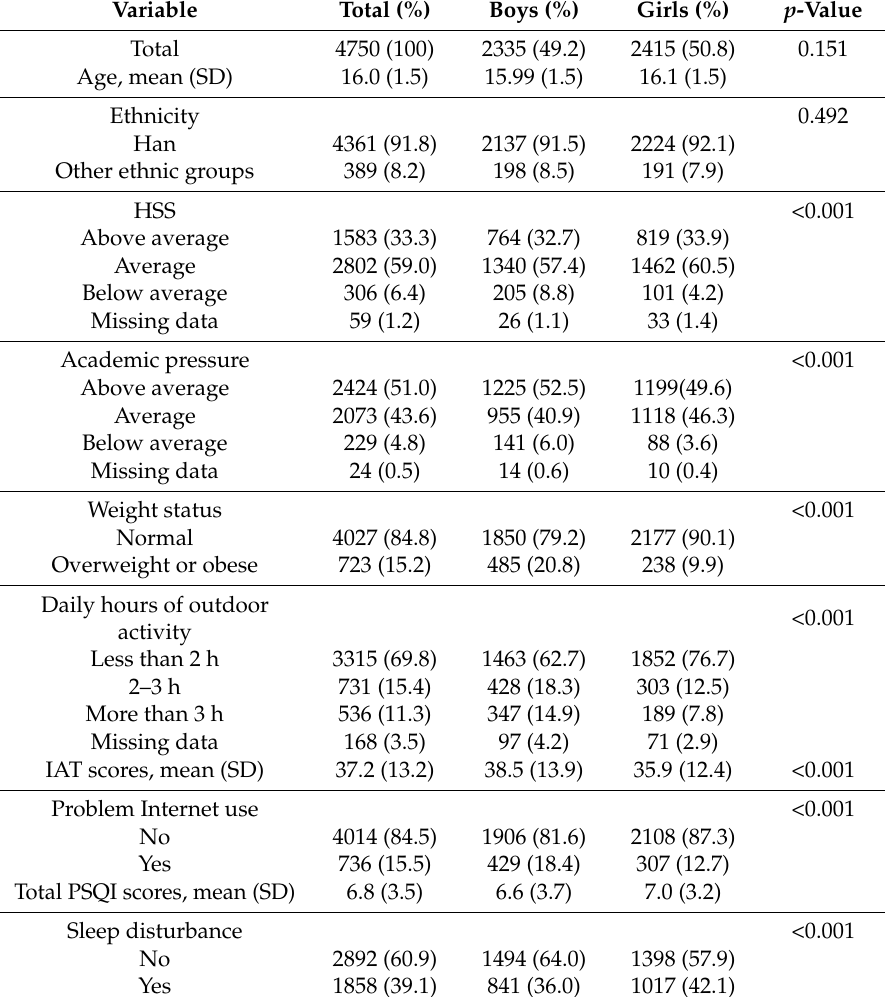
Table 1. Sample characteristics stratified by